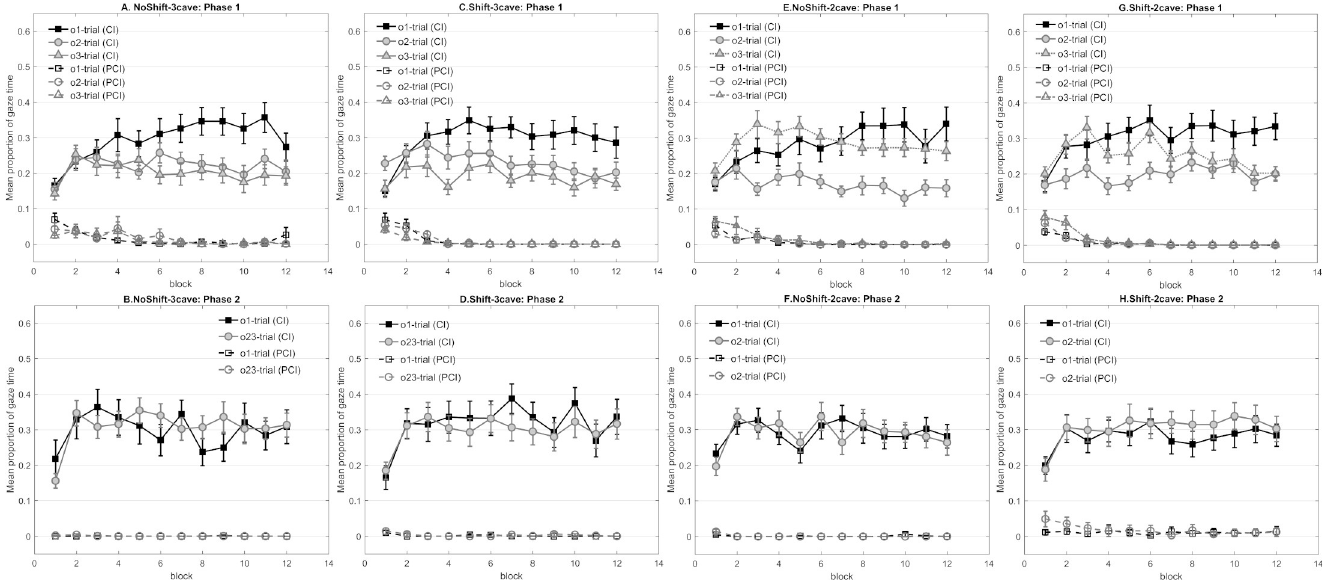
Fig 4. Panel A to H represent the mean proportion of gaze time in Experiment 2 that participants looked at the correct outcome’s cave during the cue (CI) and the pre-cue interval (PCI) respectively in each phase. (A) Mean gaze time of NoShift-3cave across the 12 blocks in Phase 1. (B) Mean gaze time of NoShift-3cave across the 12 blocks in Phase 2. (C) Mean gaze time of Shift-3cave across the 12 blocks in Phase 1. (D) Mean gaze time of Shift-3cave across the 12 blocks in Phase 2. (E) Mean gaze time of NoShift-2cave across the 12 blocks in Phase 1. (F) Mean gaze time of NoShift-2cave across the 12 blocks in Phase 2. (G) Mean gaze time of Shift- 2cave across the 12 blocks in Phase 1. (H) Mean gaze time of Shift-2cave across the 12 blocks in Phase 2. Note that i) gaze time in Phase 2 was averaged based on the predictability of each trial’s outcome in Phase 1, and ii) o3 as well as the middle cave were not presented in Phase 2 in NoShift-2cave and Shift-2cave.